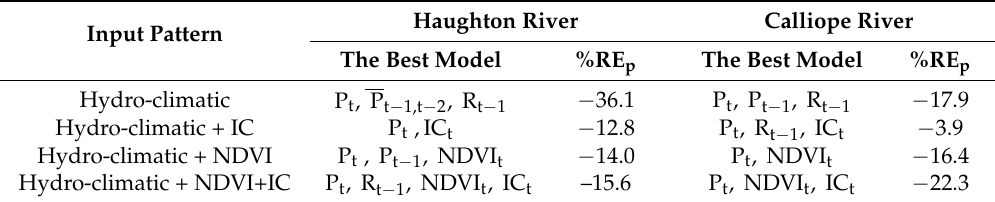
Figure 8. Time-series curves of observed runoff versus simulated runoff of the best model using only hydro-climatic inputs (bold type in Table 4) and simulated runoff of the best model using hydro-climatic inputs along with new inputs (bold type in Tables 5 and 6) during the validation phase for the Haughton River catchment ( a ) and the Calliope River catchment ( b ). Table 7. Assessment of models based on relative error in peak runoff for the best model using only hydro-climatic inputs and the best model using hydro-climatic inputs along with new inputs for Haughton River and Calliope River